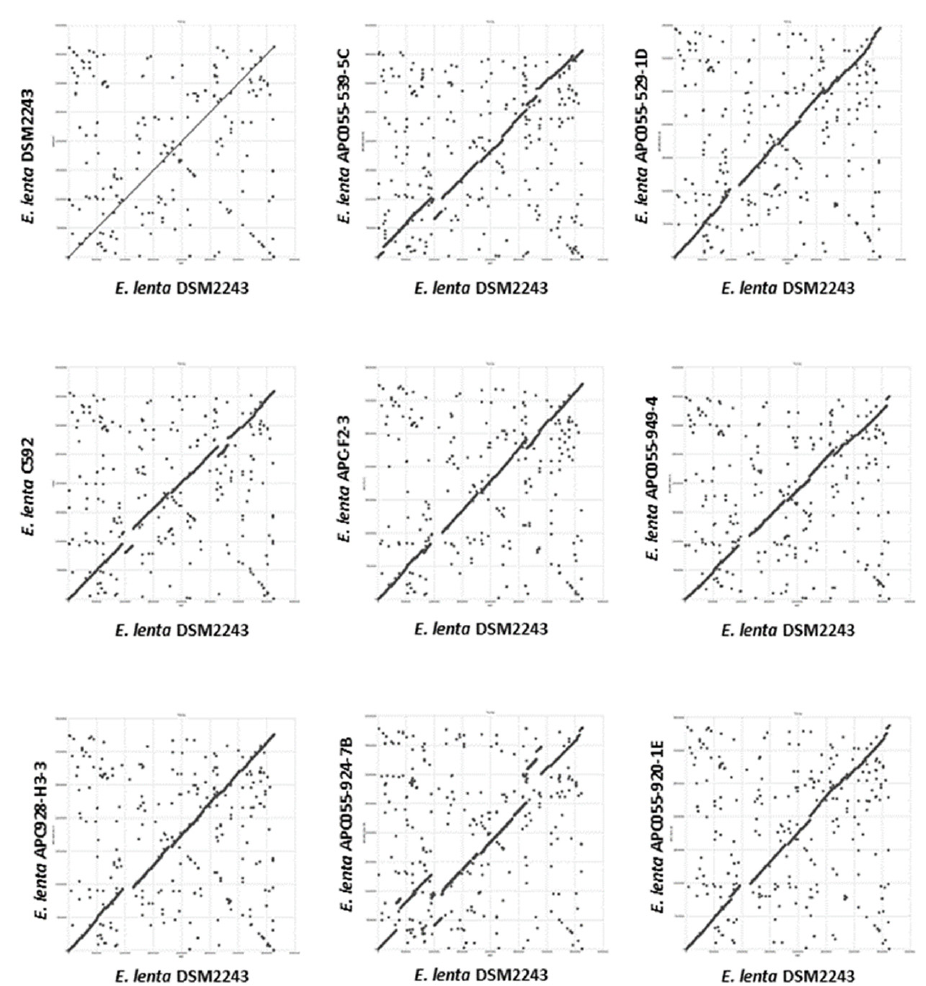
Figure 1. Dot plot illustrating whole genome alignment (MUMmer) of seven E. lenta strains isolated in this study (denoted with the APC prefix) and those publicly available (C592 and DSM2243) with the genome of the type strain DSM2243.